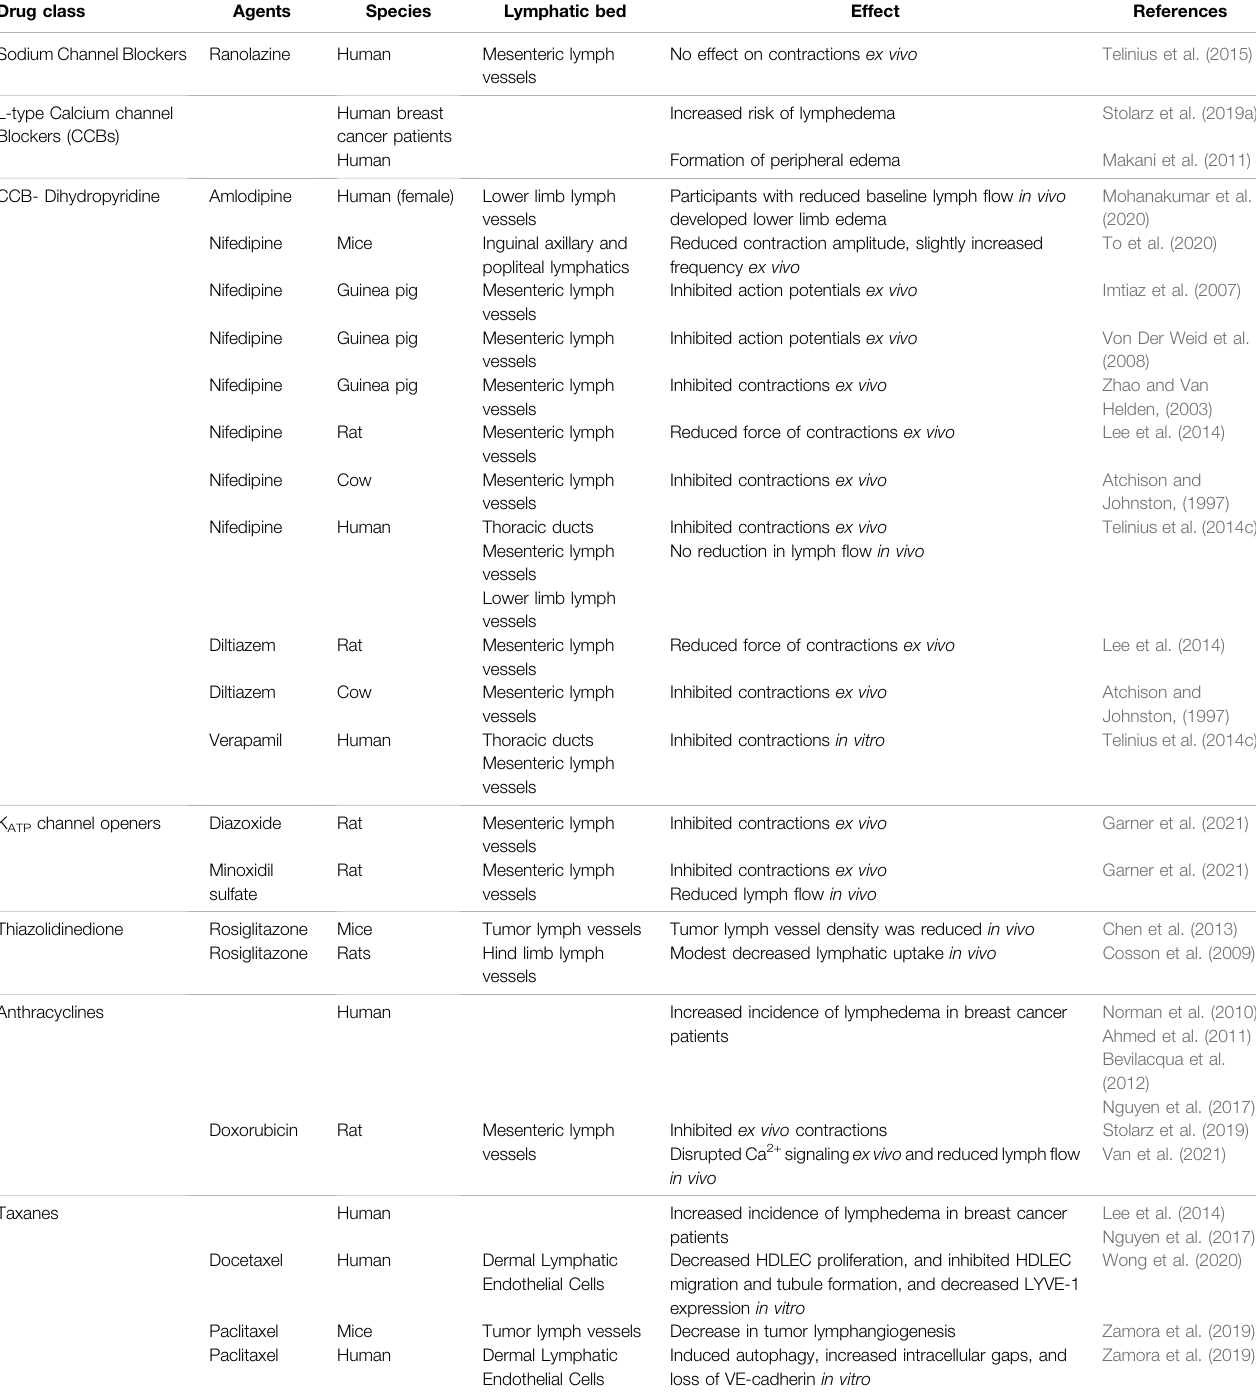
TABLE 1 | Effect of common clinical drugs on the lymphatic